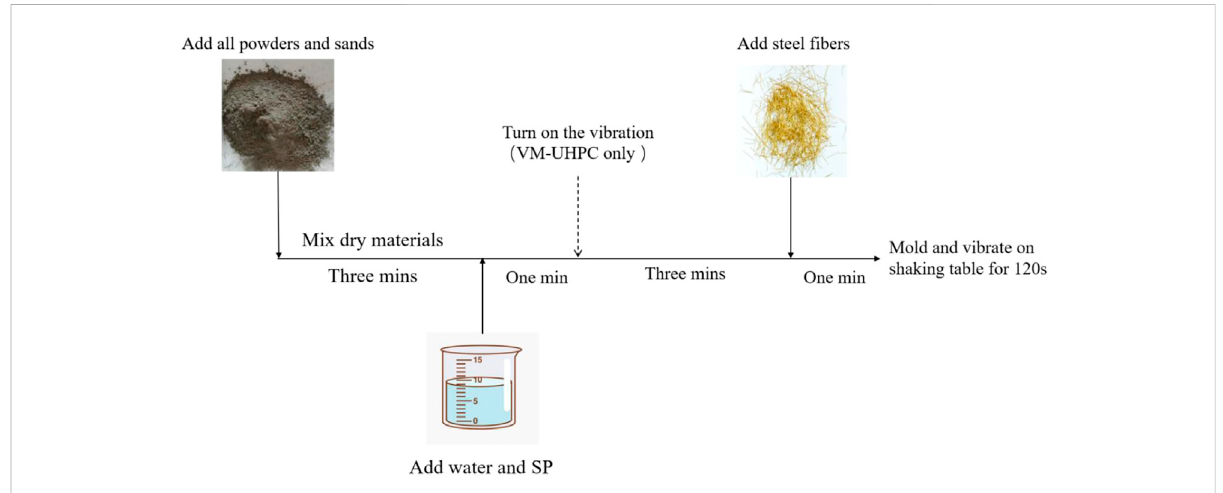
FIGURE 8 Steel fi ber-reinforced UHPC mixing process (Zheng et al.,